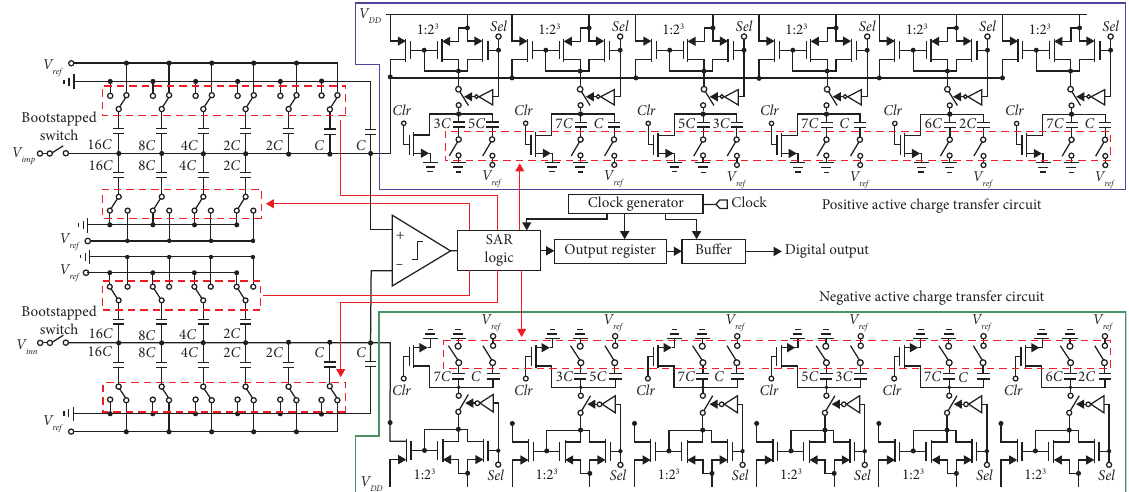
Figure 24: Te pseudo-two-stage SAR with active charge-transferring technique [66].